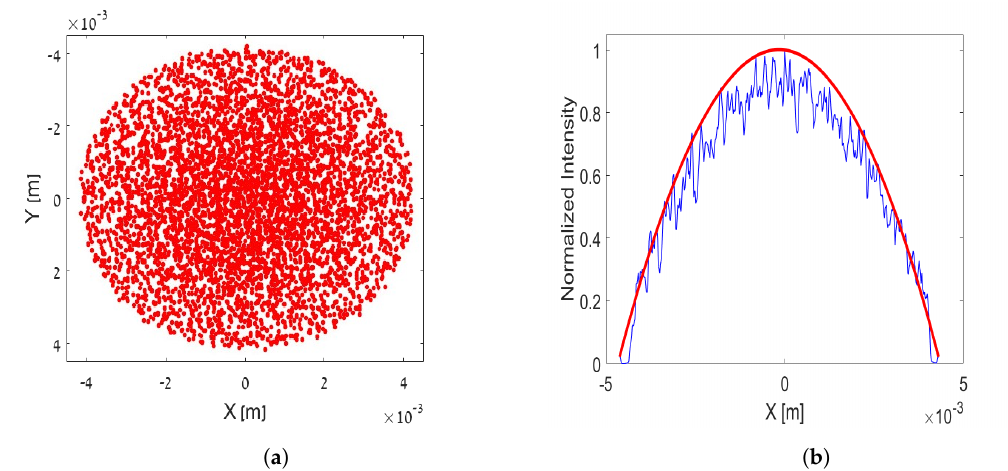
Figure 2. ( a ) Transverse density extracted from GPT Simulation of a propagating Gaussian electron beam (before the slit-mask) where each dot represents a macro-particle in the simulation. ( b ) Beam profile of ( a ).